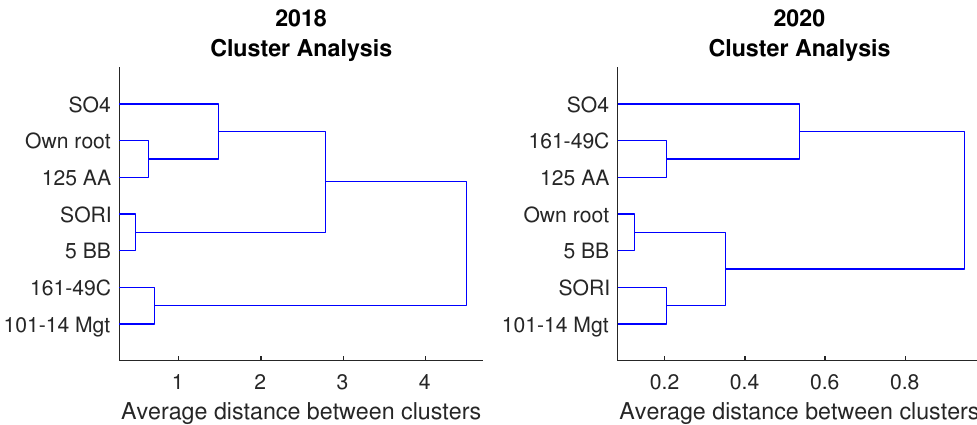
Figure 2. Cluster analysis of Regent grapevine total yield considered in the extreme years of the study.